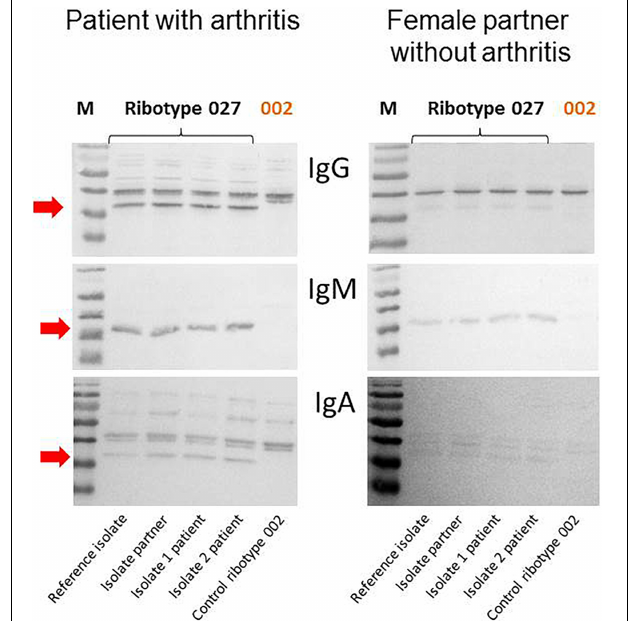
FIGURE 2 | Strong humoral immune response of the patient against SlpA of three RT027 strains (reference strain, isolate of the female partner, two isolates of the patient) but not against a ribotype 002 control isolate. The arrow marks the humoral immune response against the immunodominant protein